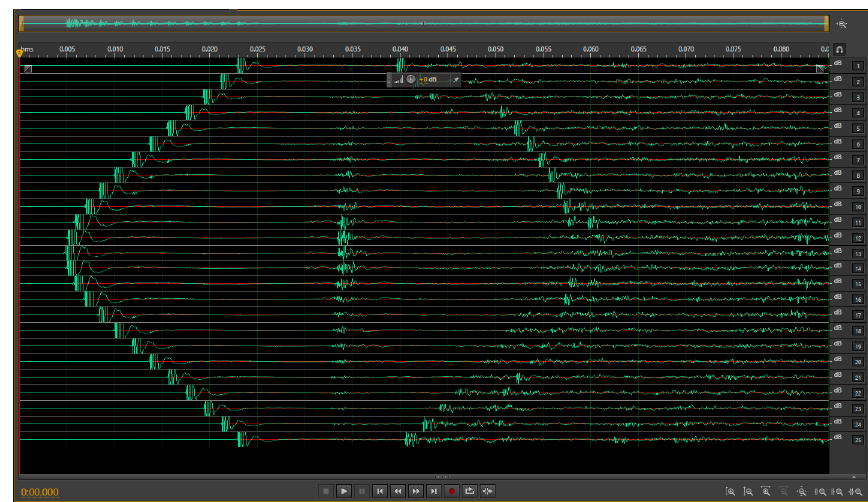
Figure 5. Example of a polar plot of RIR data measured inside Room B: direct sound on the left, early reflections in the center and late reflections on the right.